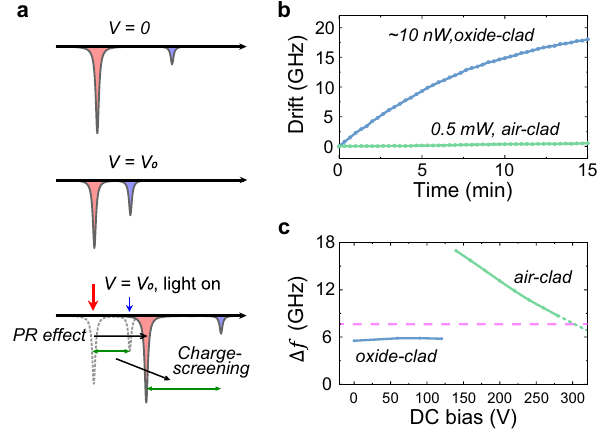
Fig. 2 Mitigation of the photorefractive effect. a Illustration of the PR- induced resonance instability resulting from a combination of absolute frequency shift and cancellation of voltage tunability after illumination. b The measured resonance frequency drift at zero-bias voltage after light illumination of oxide-clad (blue) and air-clad (green) architecture. The drift rate of the measured air-clad device is (cid:2) 0 : 28 pm = min under 0.5 mW optical power in the waveguide. c The optical supermode splitting Δ f as a function of DC bias for oxide-clad (blue) and air-clad (green) devices. The target microwave frequency is marked as a dashed